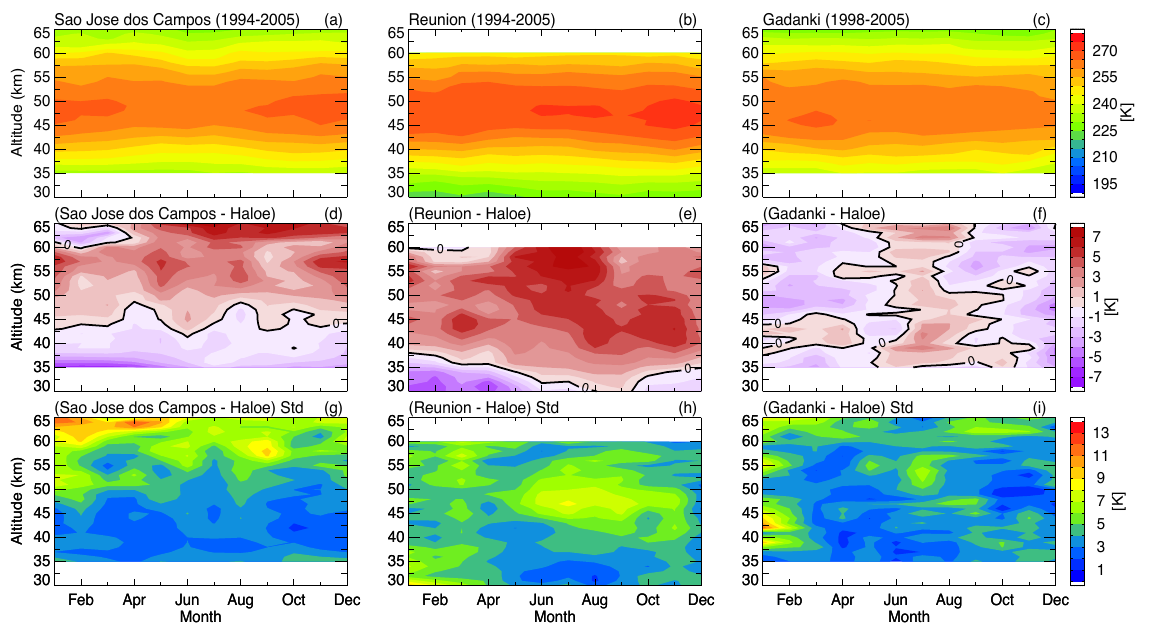
Fig. 2. Monthly mean temperature observed over (a) São José dos Campos, (b) Reunion, and (c) Gadanki averaged during 1994–2005, 1994–2005, and 1998–2005, respectively. Monthly mean temperature difference and standard deviations observed between HALOE and respective lidars are shown in (d) – (f) and (g) – (i), respectively.